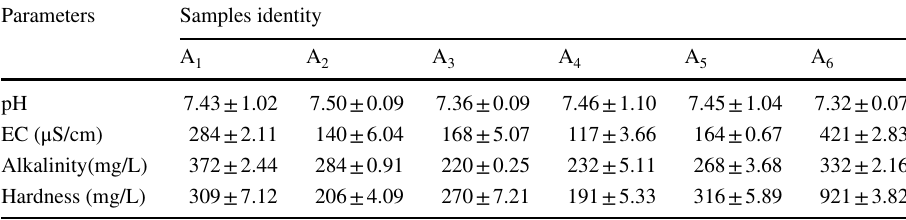
Table 1 Physical properties of water from the shallow wells from Anloga